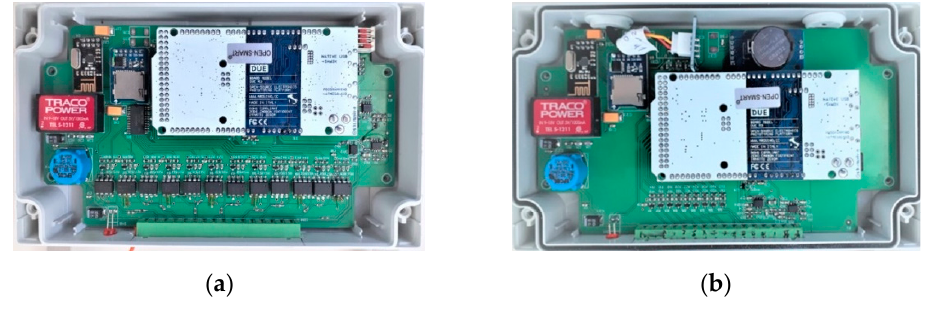
Figure 4. ( a ) Capture unit; ( b ) Master unit.